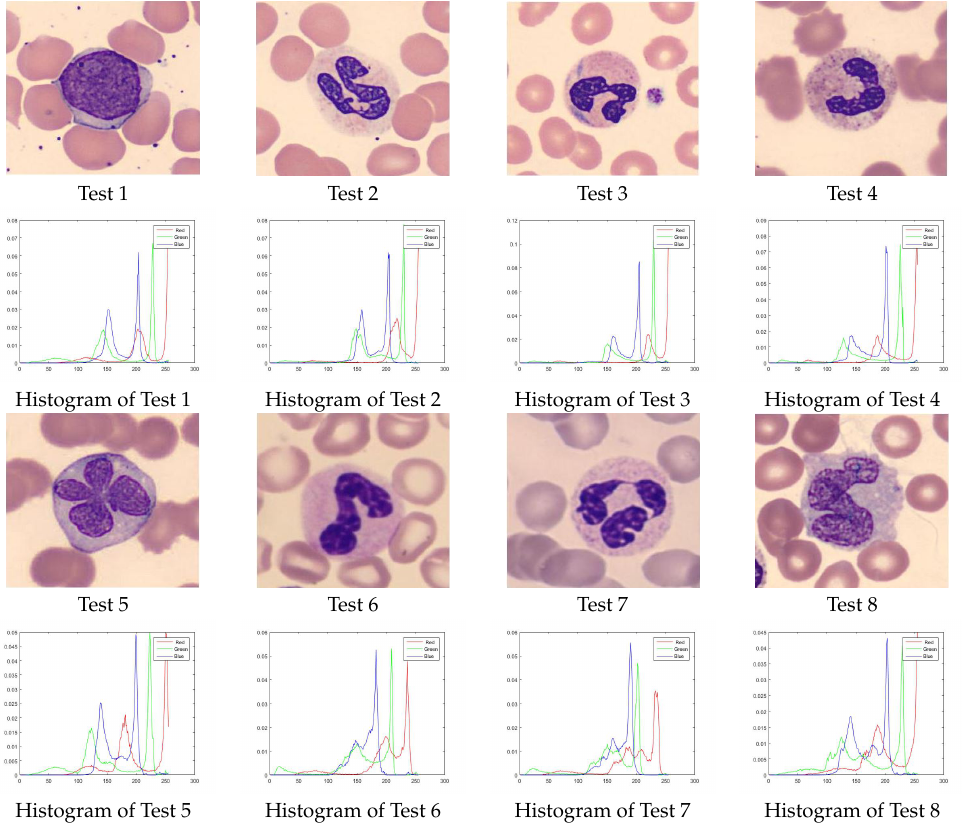
Figure 7. Set of test images and relative histograms. Table 3. The parameter settings of the mSAR algorithm and its